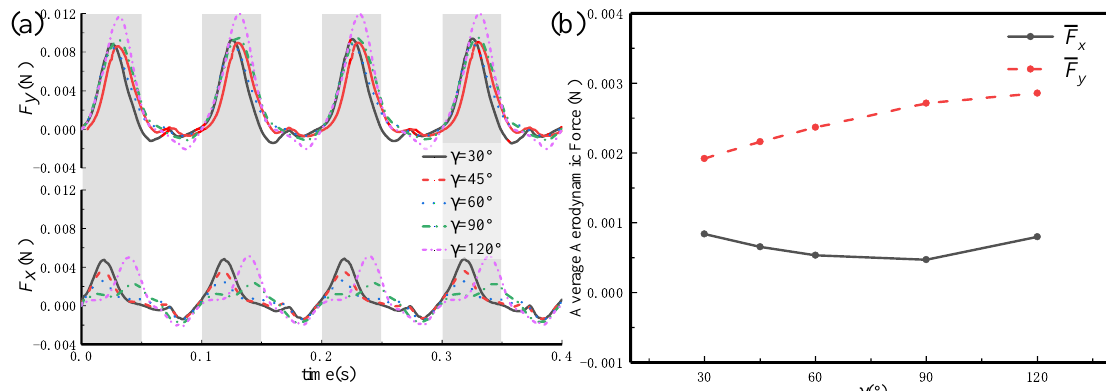
Figure 10. ( a ) The instantaneous aerodynamic forces of the butterfly accompanied by the change of γ in four flapping cycles; and ( b ) the average aerodynamic forces at different phase differences.